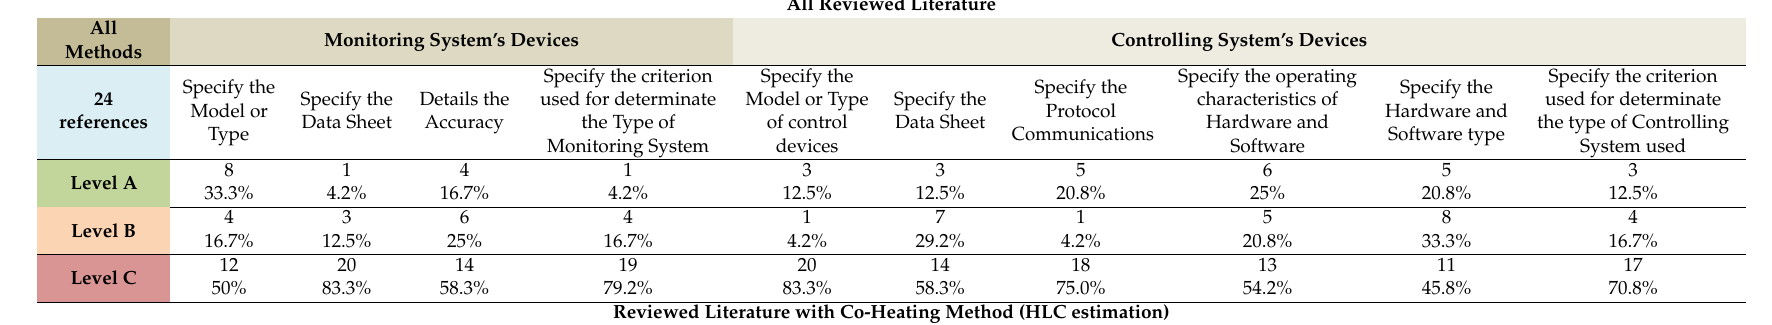
Table 13. Quantitative analysis of specification level’s degree of the analyzed criteria of MCSs used in buildings or prototypes in the reviewed